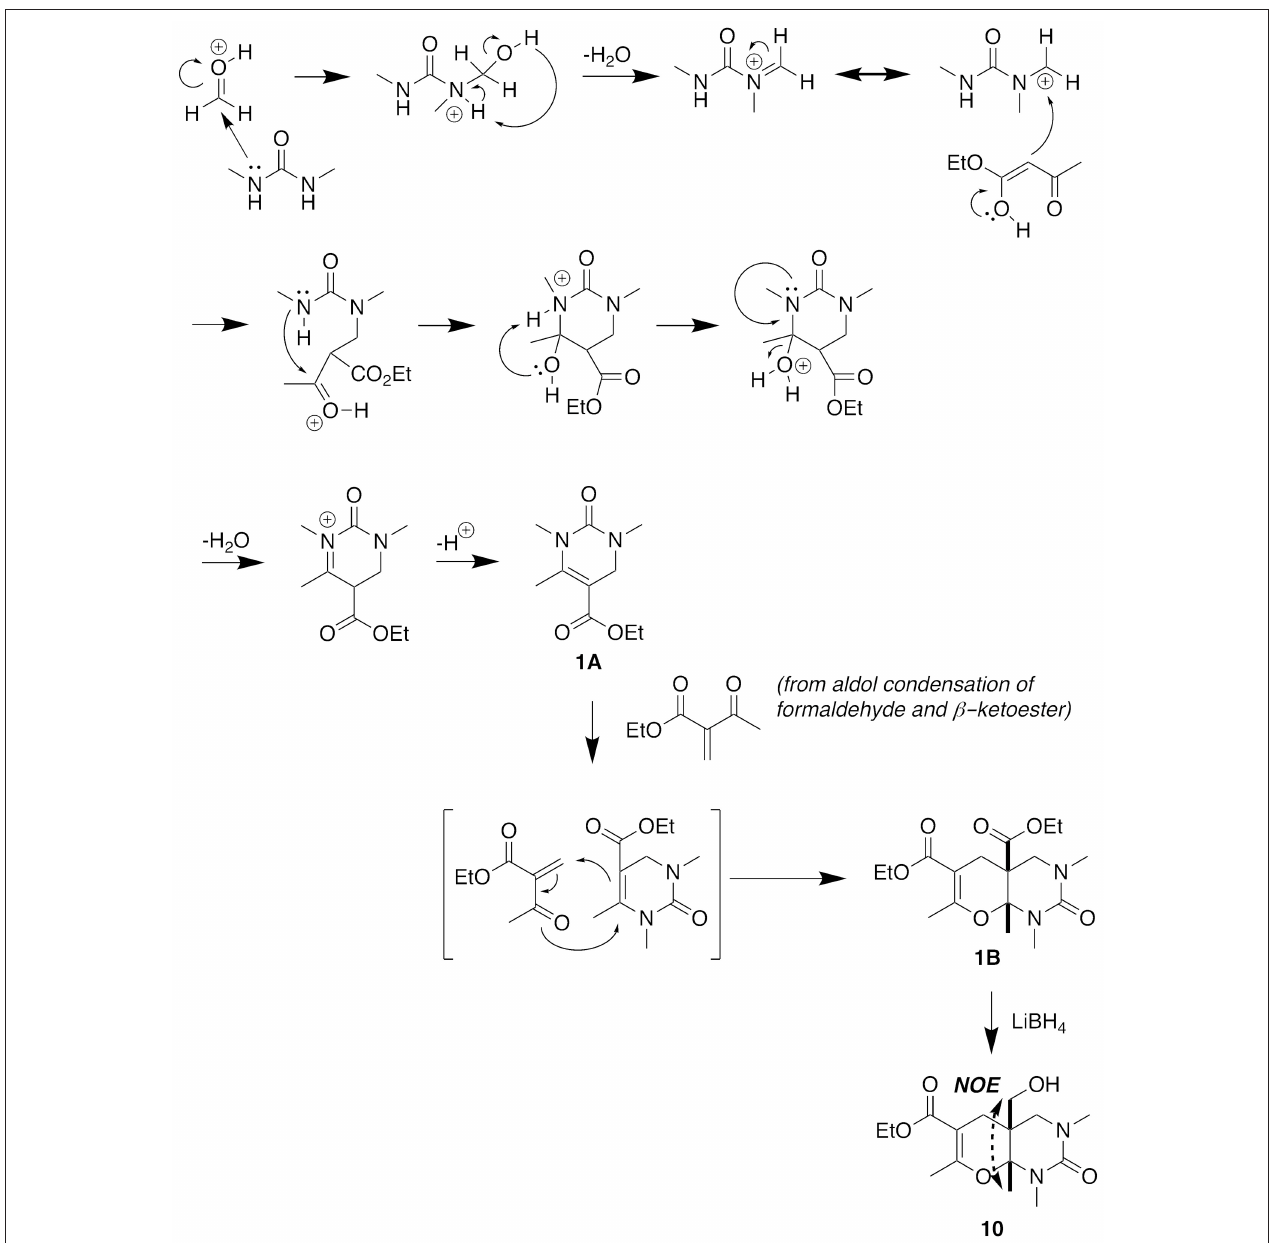
FIGURE 7 | Proposed mechanism of five-component